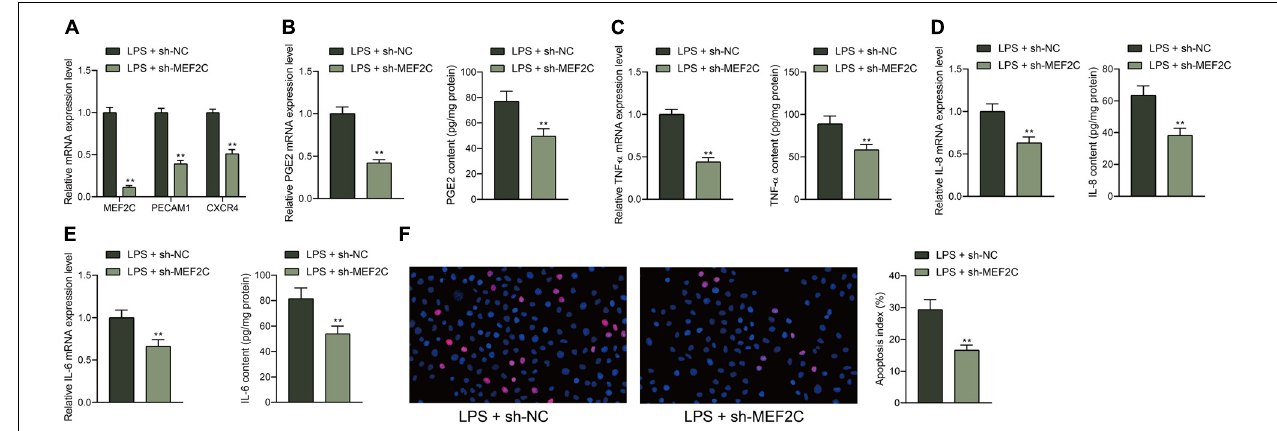
FIGURE 6 | Knockdown of MEF2C reduces LPS-induced inflammation and apoptosis in HDPFs. (A) mRNA expression of MEF2C, PECAM1, and CXCR4 in cells after sh-MEF2C transfection examined by RT-qPCR. (B–E) mRNA and protein levels of inflammatory cytokines PGE2, TNF- α , IL-6, and IL-8 in cells examined by RT-qPCR and ELISA kits. (F) Apoptosis of HDPFs after sh-MEF2C transfection examined by TUNEL assay. Data were collected from three individual experiments and expressed as mean ± SD. Data were analyzed by the unpaired t- test (B–F) or two-way ANOVA (A) followed by Tukey’s multiple comparison test. ** p < 0.01 vs. LPS +